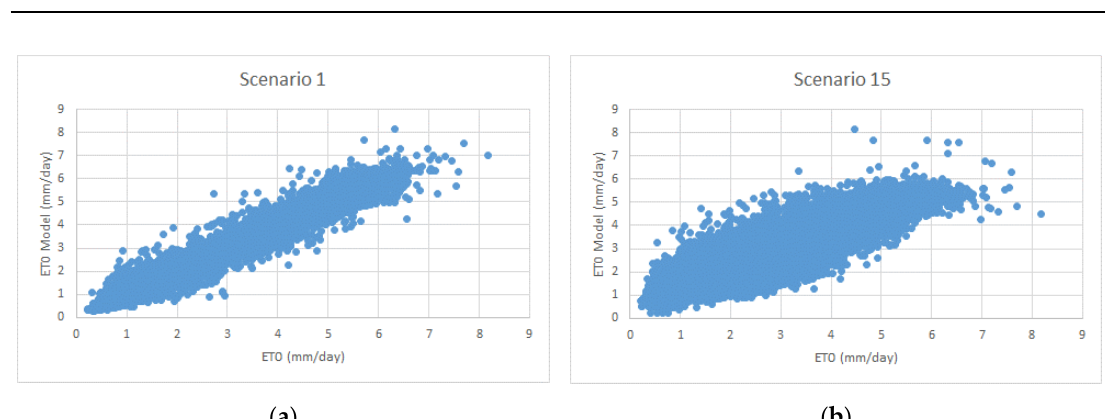
Figure 7. Scatter plot of the RF method for ( a ) Scenario 1 and ( b ) Scenario 15.